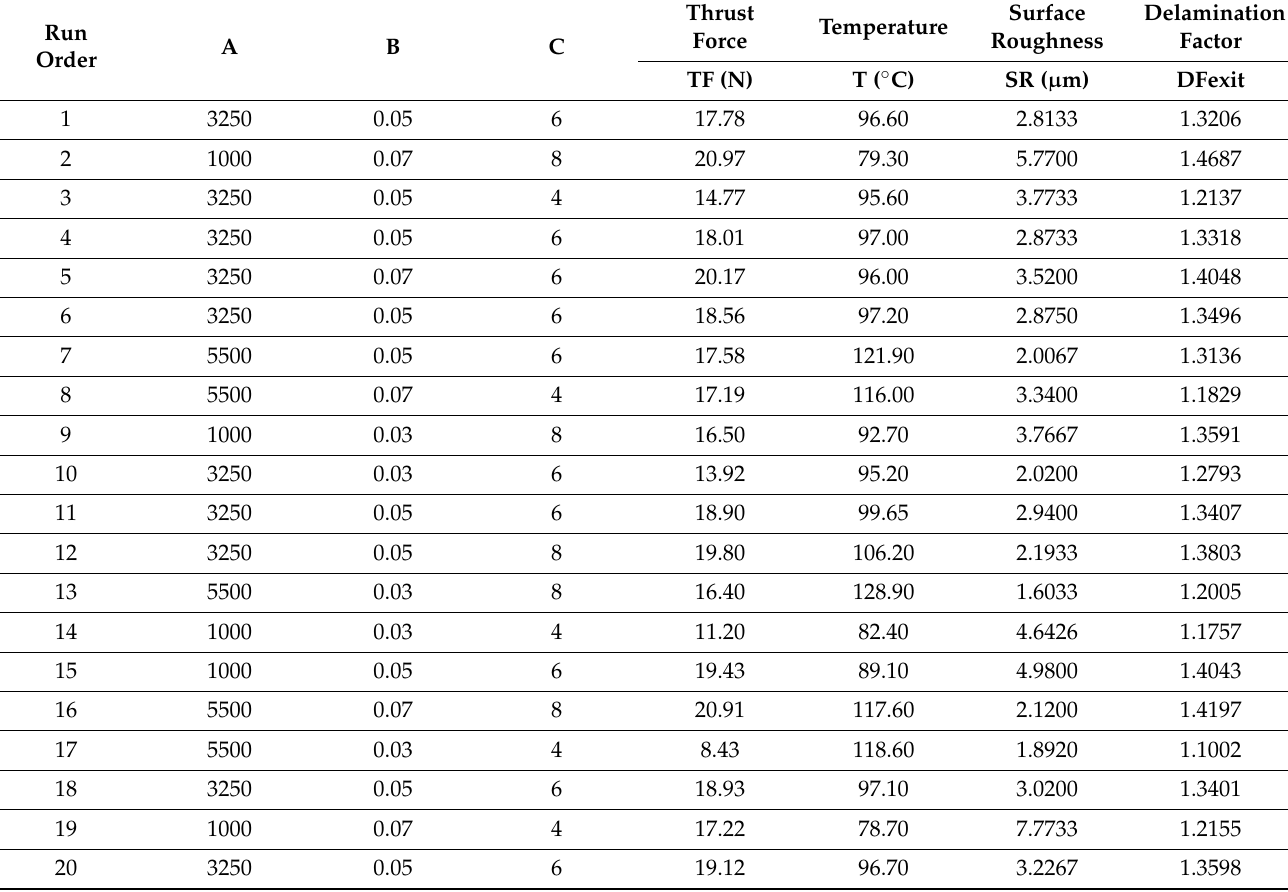
Table 3. Drilling experiment design matrix and responses of carbon fabric–neat